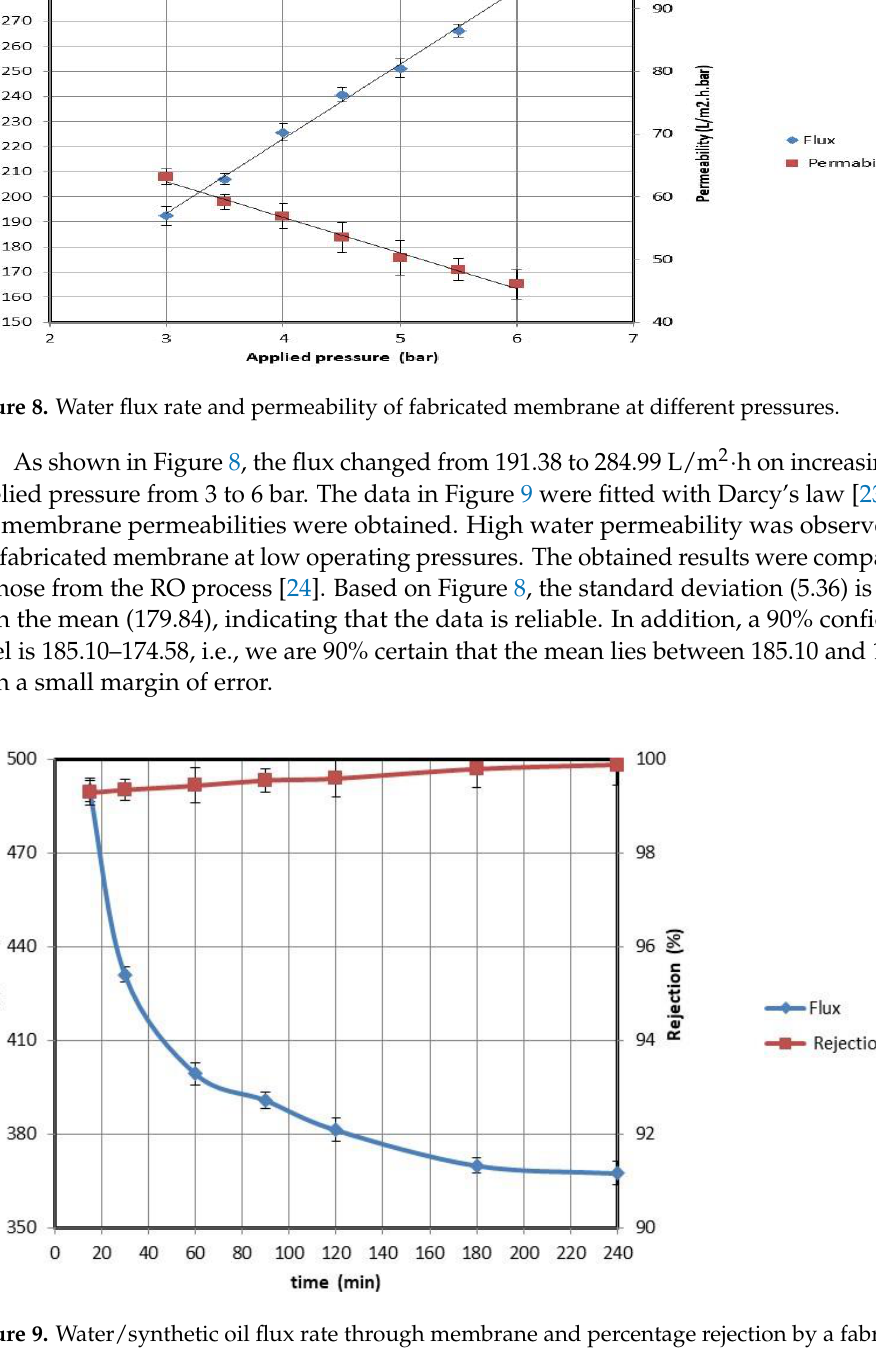
Figure 9. Water/synthetic oil flux rate through membrane and percentage rejection by a fabricated membrane at different times. Figure 9 shows that the water flux rate decreased over 4 h from 490.28 to 367.32 L/m 2 ·h. This behavior could be due to a considerable quantity of oil deposited on the mem- brane over the course of testing, resulting in a decreased flux through membrane fouling.